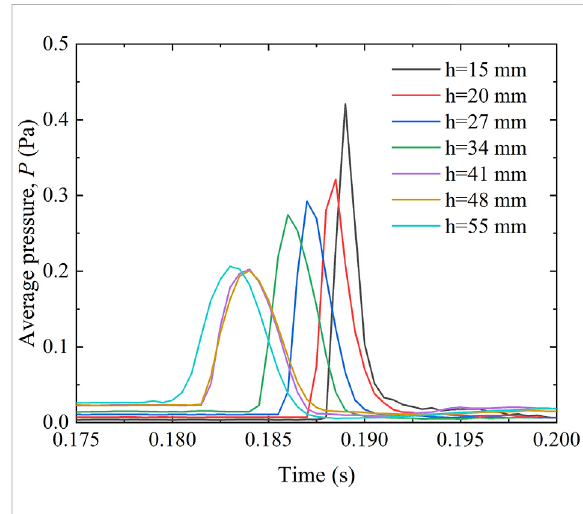
FIGURE 7 Evolution and comparison of theimpactaverage pressure for the rockfall impacting against the granular material of buffering (sphere-cylinder) with different thicknesses of the particle layer.